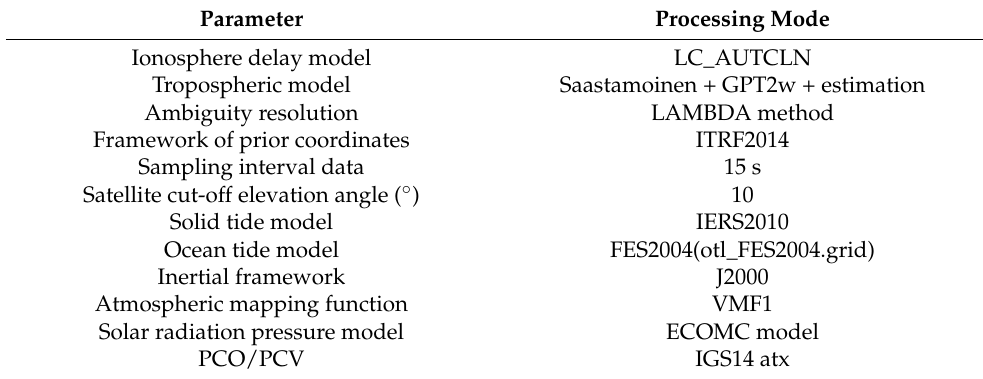
Figure 1. Location of GNSS stations in SGNR. Table 1. The main parameters used in the GAMIT calculation.